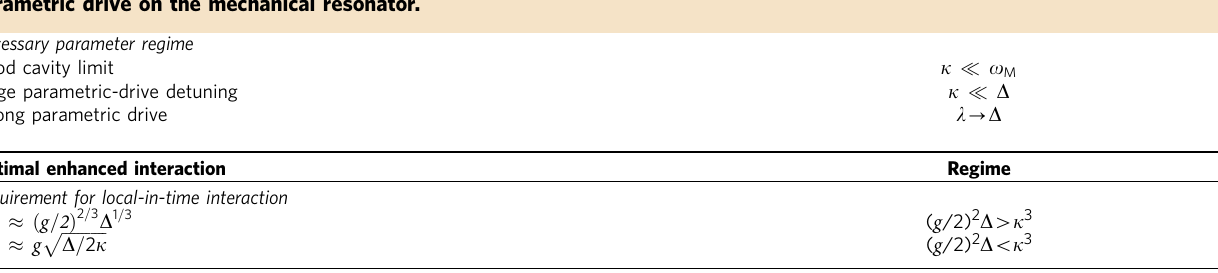
Table 1 | Parameter regime needed to get important amplification of the single-photon coupling constant ~ g ¼ ge r = 2 using a parametric drive on the mechanical